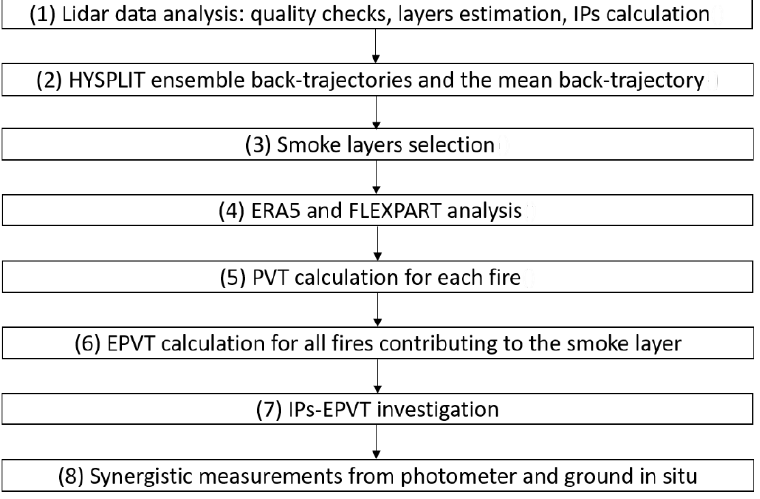
Figure 1. Methodology diagram.